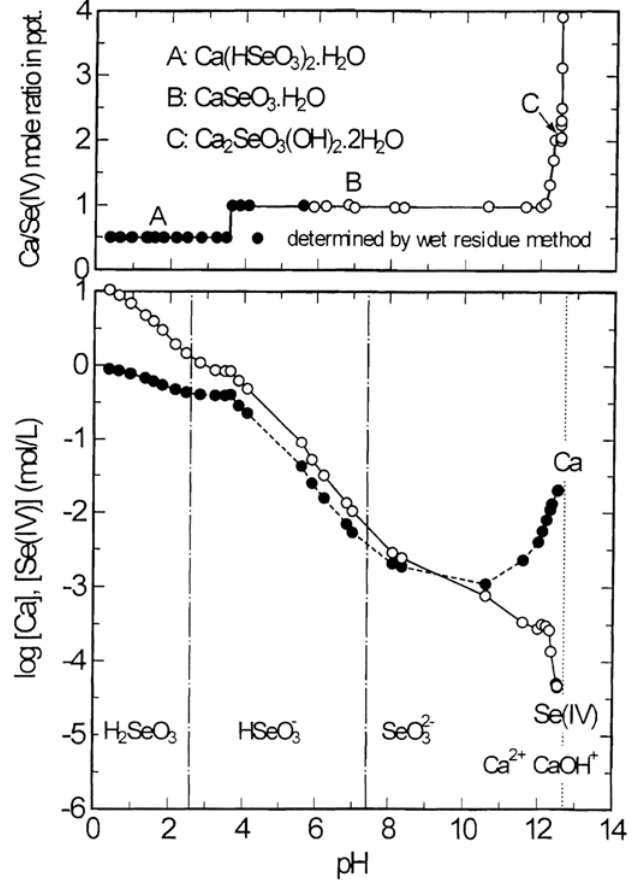
Figure 4. Stability and solubility regions for calcium selenites as a function of pH at 25 °C.